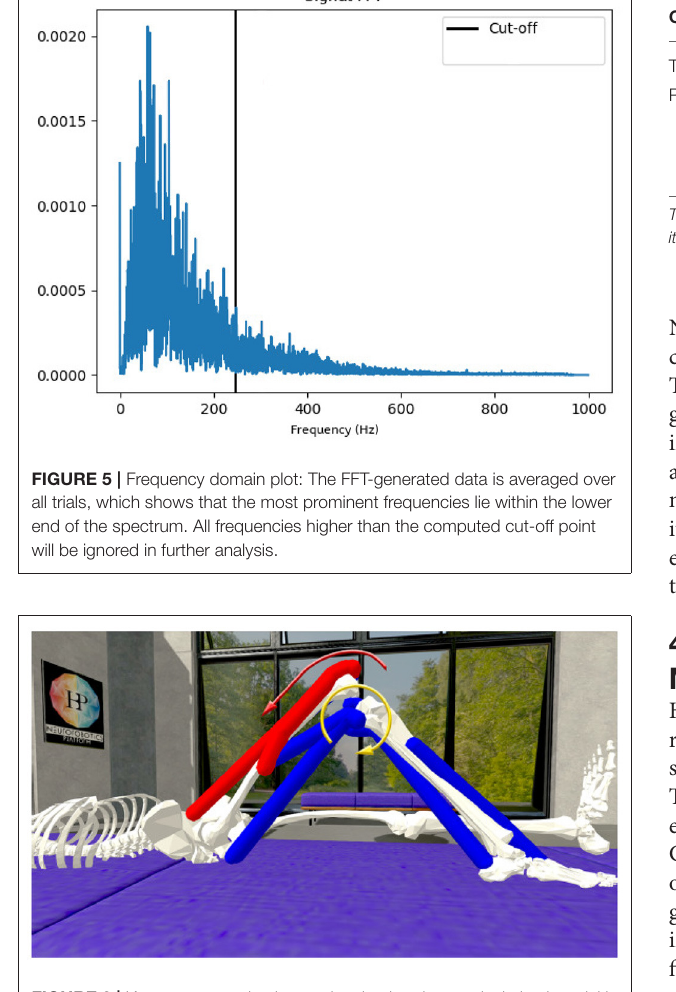
FIGURE 6 | Knee torque evaluation on the simulated musculoskeletal model in the Neurorobotics Platform: Muscles are activated (muscle color coding: blue—no activation, red—maximal activation) by either processed EMG signals or a Genetic Algorithm and results in a muscle generated knee torque (red arrow). A counter acting knee torque (yellow arrow) is iteratively increased until the goal knee angle is